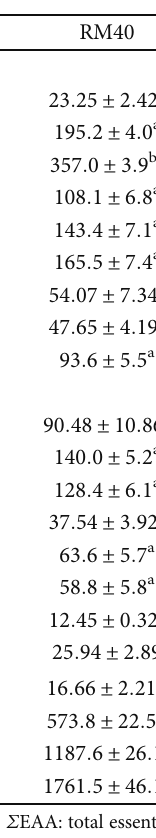
Values are means ± S.E.M of three replications. Means in the same line with di ff erent superscripts are signi fi cantly di ff erent ( P < 0 : 05 ). Σ EAA: total essential amino acids. Σ NEAA: total nonessential amino acids. Σ AA: total amino RM10 diet and lower in yellow cat fi sh fed the RM40 diet